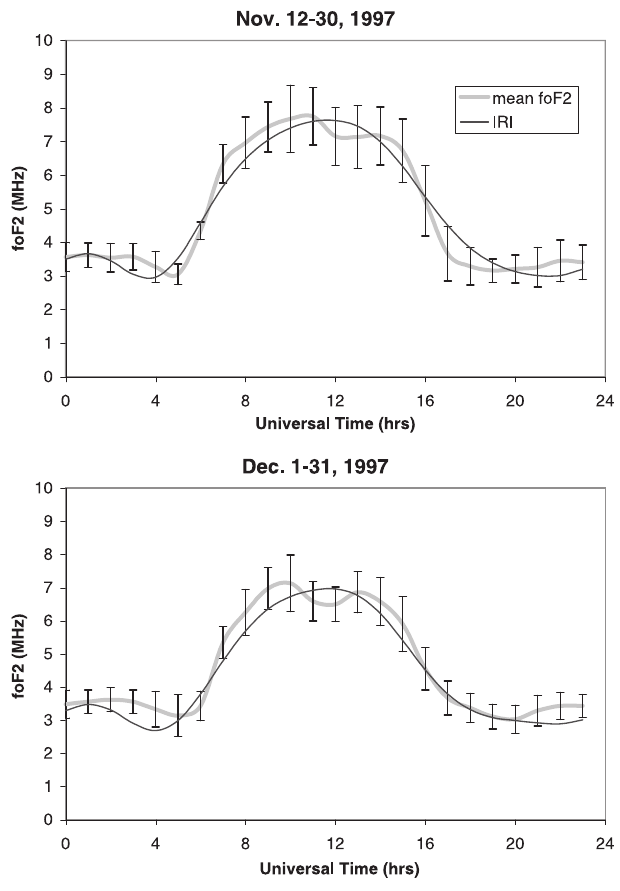
Fig. 2. Mean and standard deviation of the diurnal variation of foF2 at Rome for November and December, 1997, together with the prediction from the International Reference